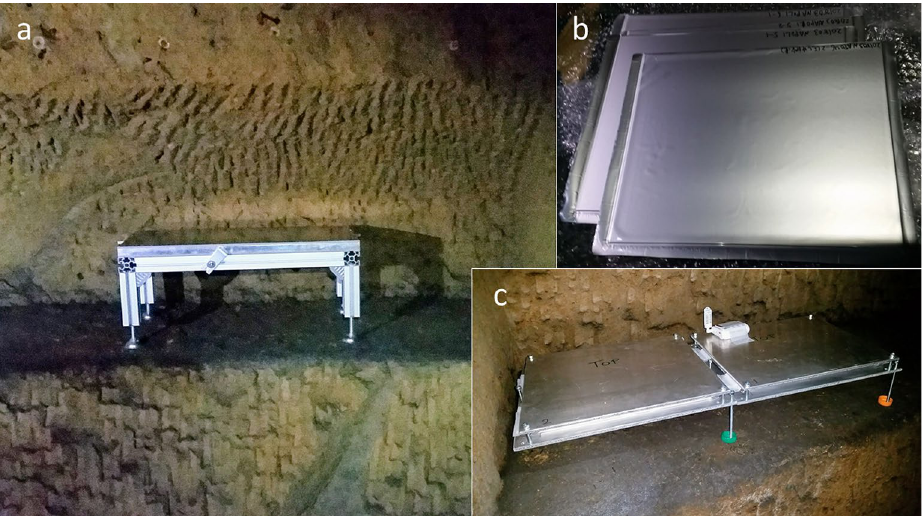
Figure 3. ( a ) Emulsion detector VP2 while taking data installed underground in the U15 “Chianca” room at 18 m depth. ( b ) Emulsion plates sealed inside protective envelopes.( c ) Emulsion detector VP1 taking data in parallel in a different position inside the same cellar. The total sensitive area of each detector is 1500 cm